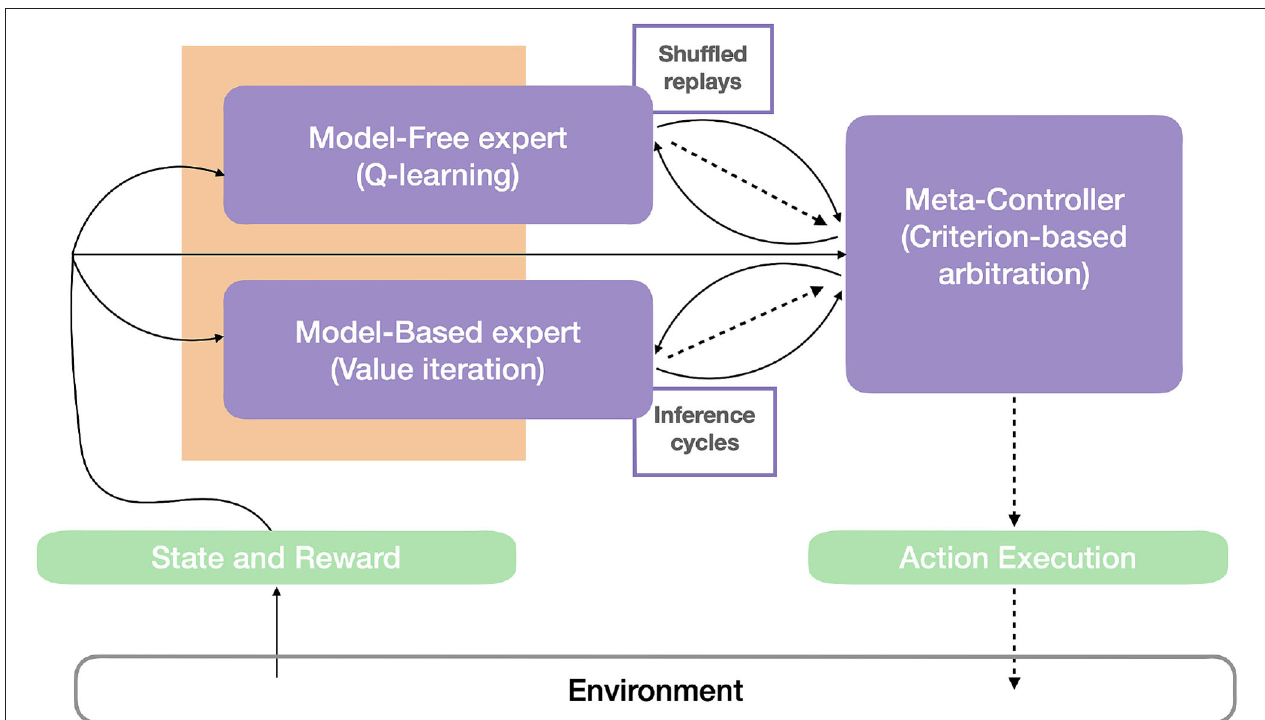
FIGURE 7 | Robot control architecture. The agent-environment interaction can be described by (1) the state and the reward, as perceptual information (continuous arrows) from the environment, and (2) by the action (dashed lines) that the agent operates in the environment. The perceptual information is used by the model-free, the model-based expert, and the meta-controller (in purple). Based on this information and memory of their previous performances, the meta-controller estimates the entropy and computational cost of the experts, consistently with the criterion in Equation 13, and thus choose the expert that will be allowed to infer the probability distribution of the next agent’s actions. This distribution, and the times consumed to compute it (dashed arrows), are then sent to the meta-controller. Different from Dromnelle et al. (2020b), both experts here have a ’replay’ (reactivation) budget (limited or until convergence) that will affect both their performance and computation time and thus impact the meta-controller’s arbitration. Here, shuffled memory reactivations (MemR) are integrated with the Q-learning algorithm of the MF expert, while simulation reactivations (SimR) constitute the offline MB inference iterations in the value iteration algorithm of the MB